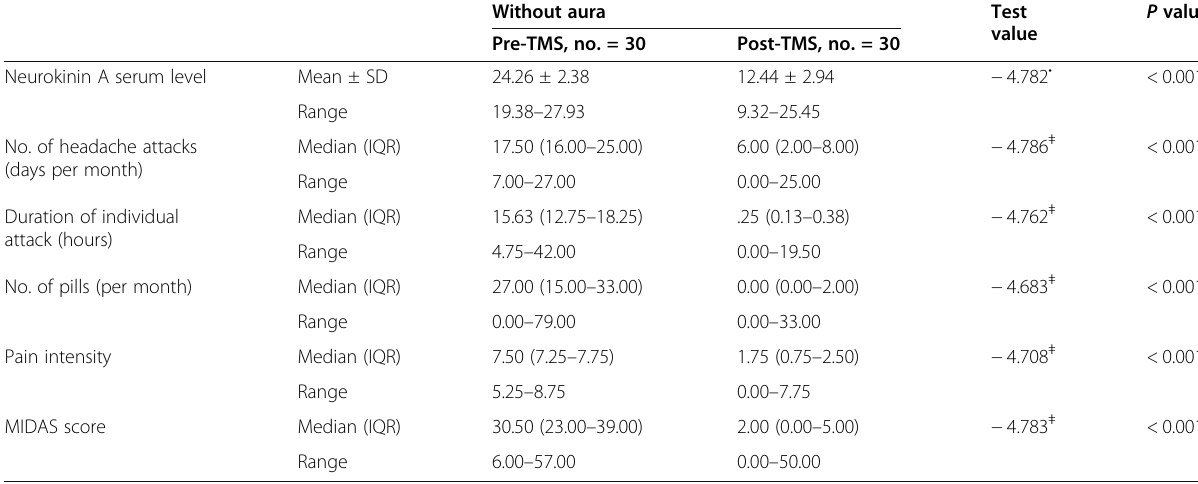
Table 3 Comparison between 4 weeks pre- and 4 weeks post-TMS as regards clinical data of migraine, MIDAS, and serum levels of neurokinin A in group A (migraine without aura) Without aura